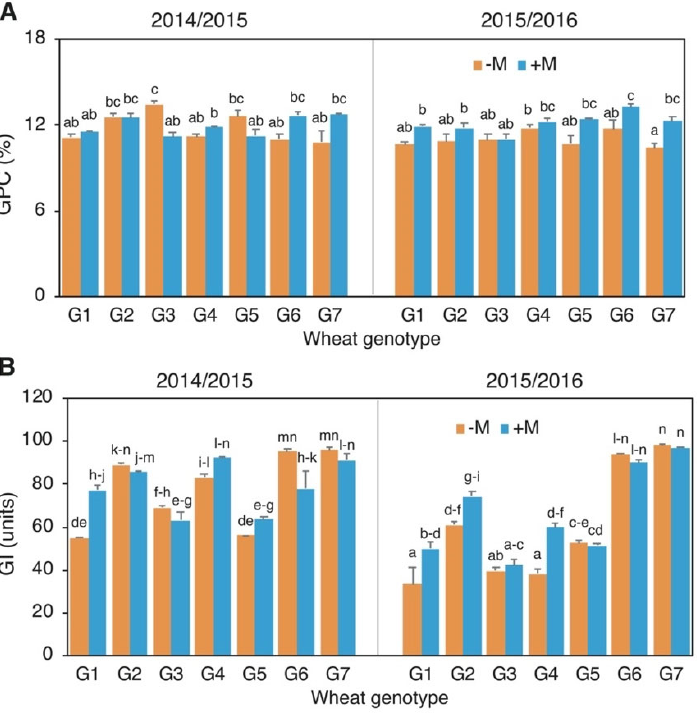
Figure 4. Effect of the interaction among wheat genotype (G), arbuscular mycorrhizal fungal inoculation (AMF), and year of cultivation (Y) (G × AMF × Y) on grain protein concentration (GCP) ( A ) and gluten index (GI) ( B ). -M: mock-AM fungal inoculated treatment (control); +M: AM fungal inoculated treatment. Wheat genotypes: G1: Gentil Rosso; G2: Risciola; G3: Frassineto; G4: Autonomia B; G5: Verna; G6: Blasco; G7: Bologna. Data are mean ± SE. Different letters indicate significant differences at P < 5% according to Tukey B test.